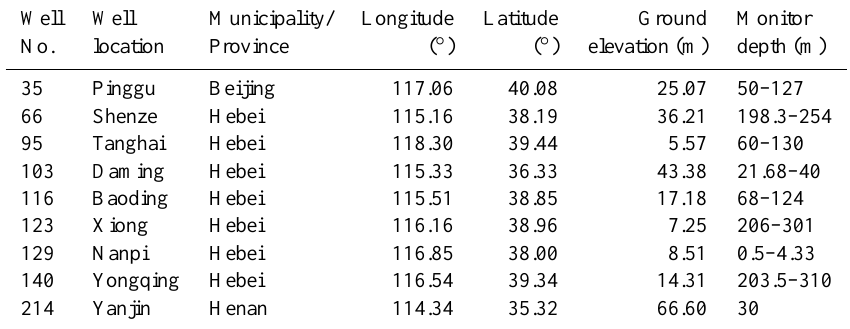
Table 5. Information of the selected groundwater observation wells used in the calibration and validation processes (Cao et al., 2013). The information includes the location information, ground elevation and monitor depth information that determines how deep the observed heads are measured in.